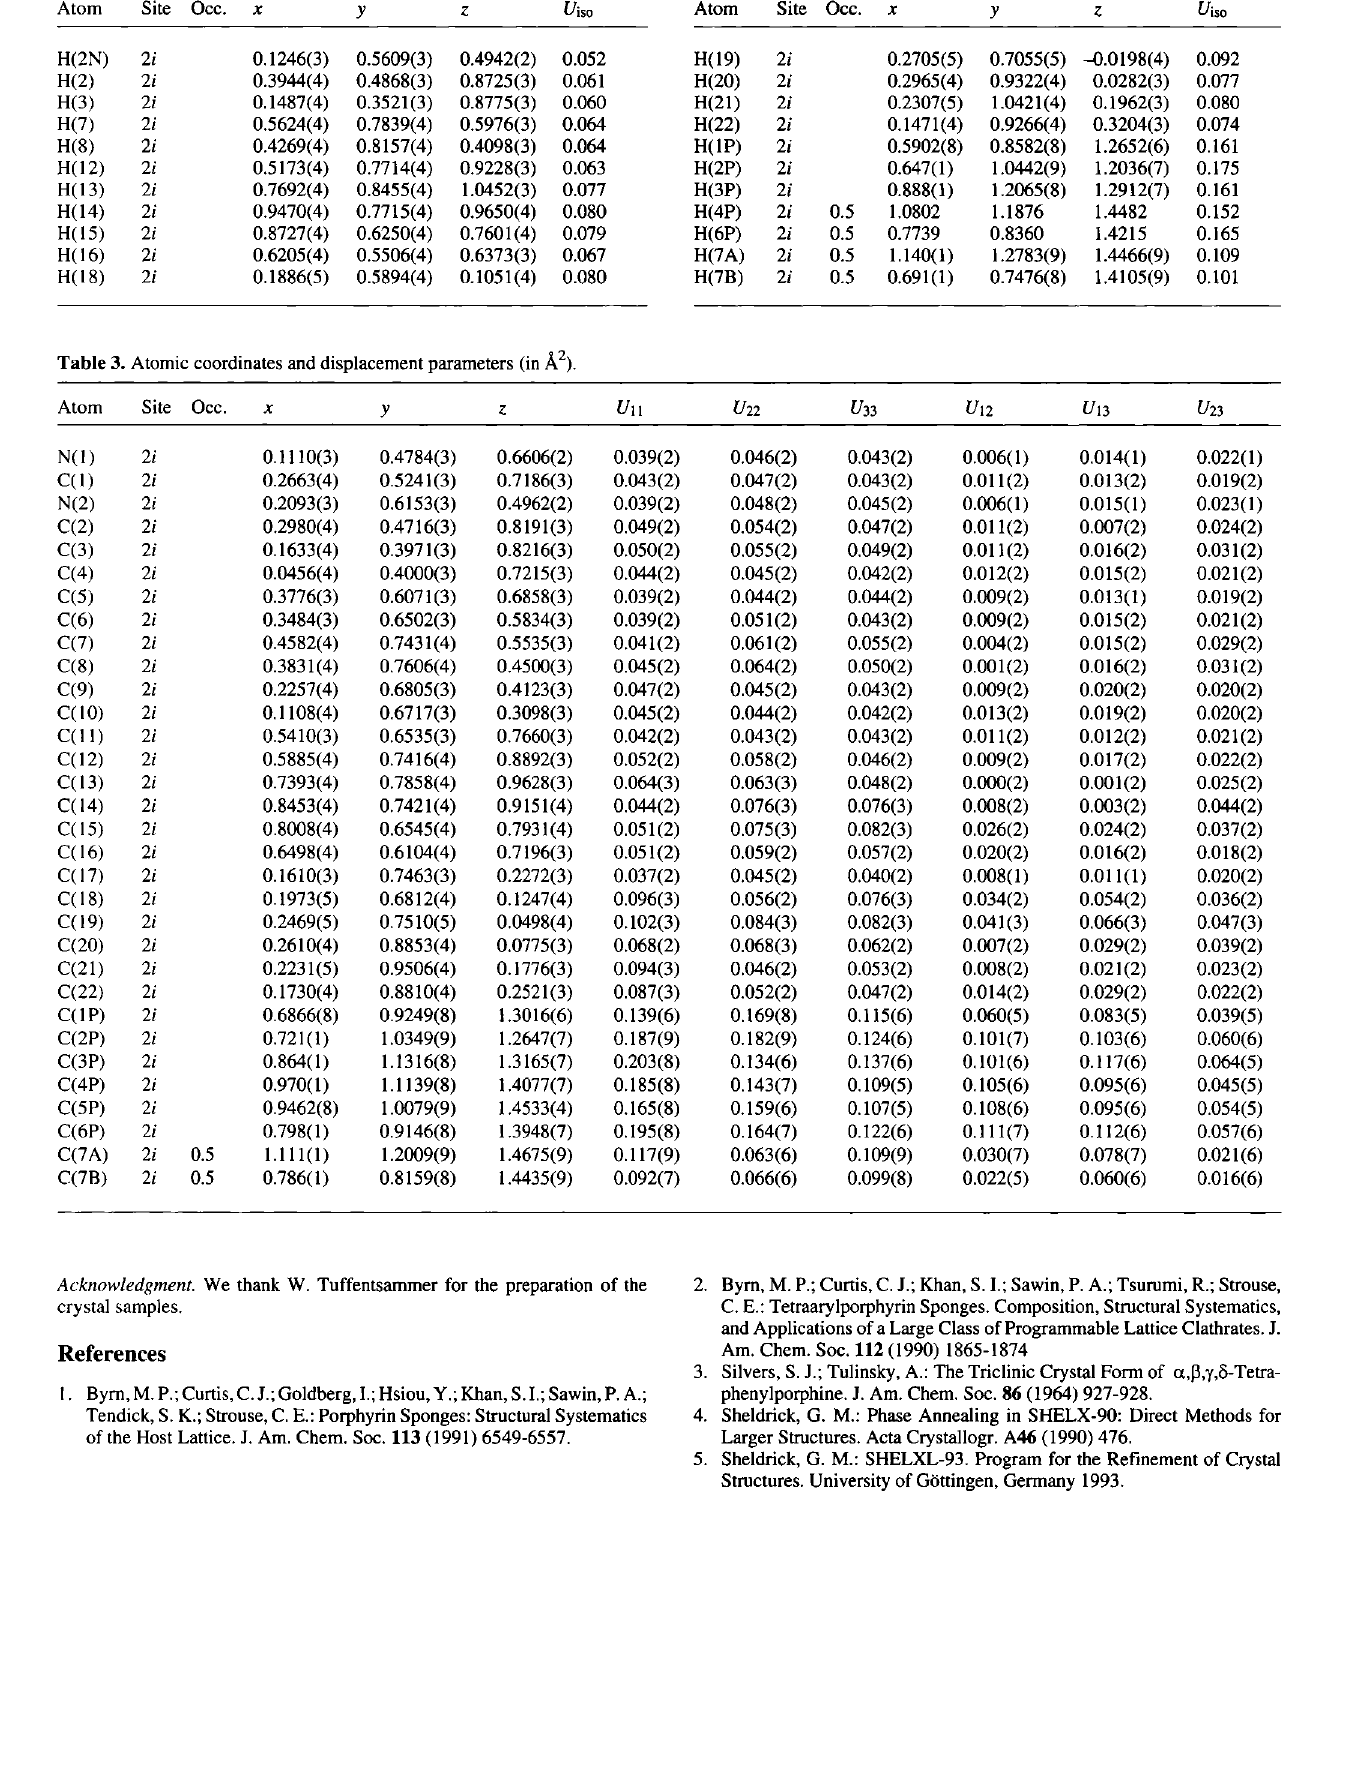
Table 3. Atomic coordinates and displacement parameters (in Ä 2 ). Atom Site